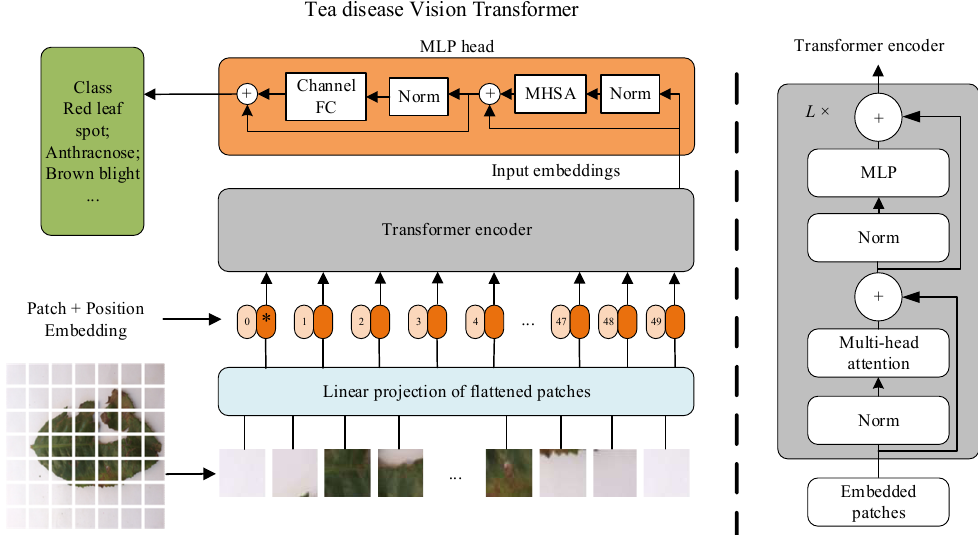
Figure 2. Model structure of Vision Transformer (ViT) for tea